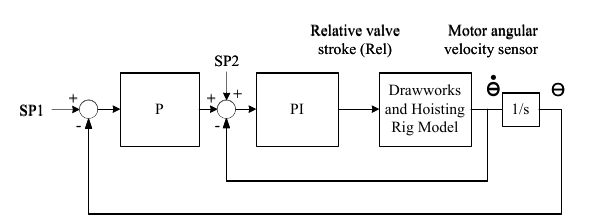
Figure 5. Cascade control architecture for the draw-works. Fig. 5 Cascade control architecture for the draw-works.